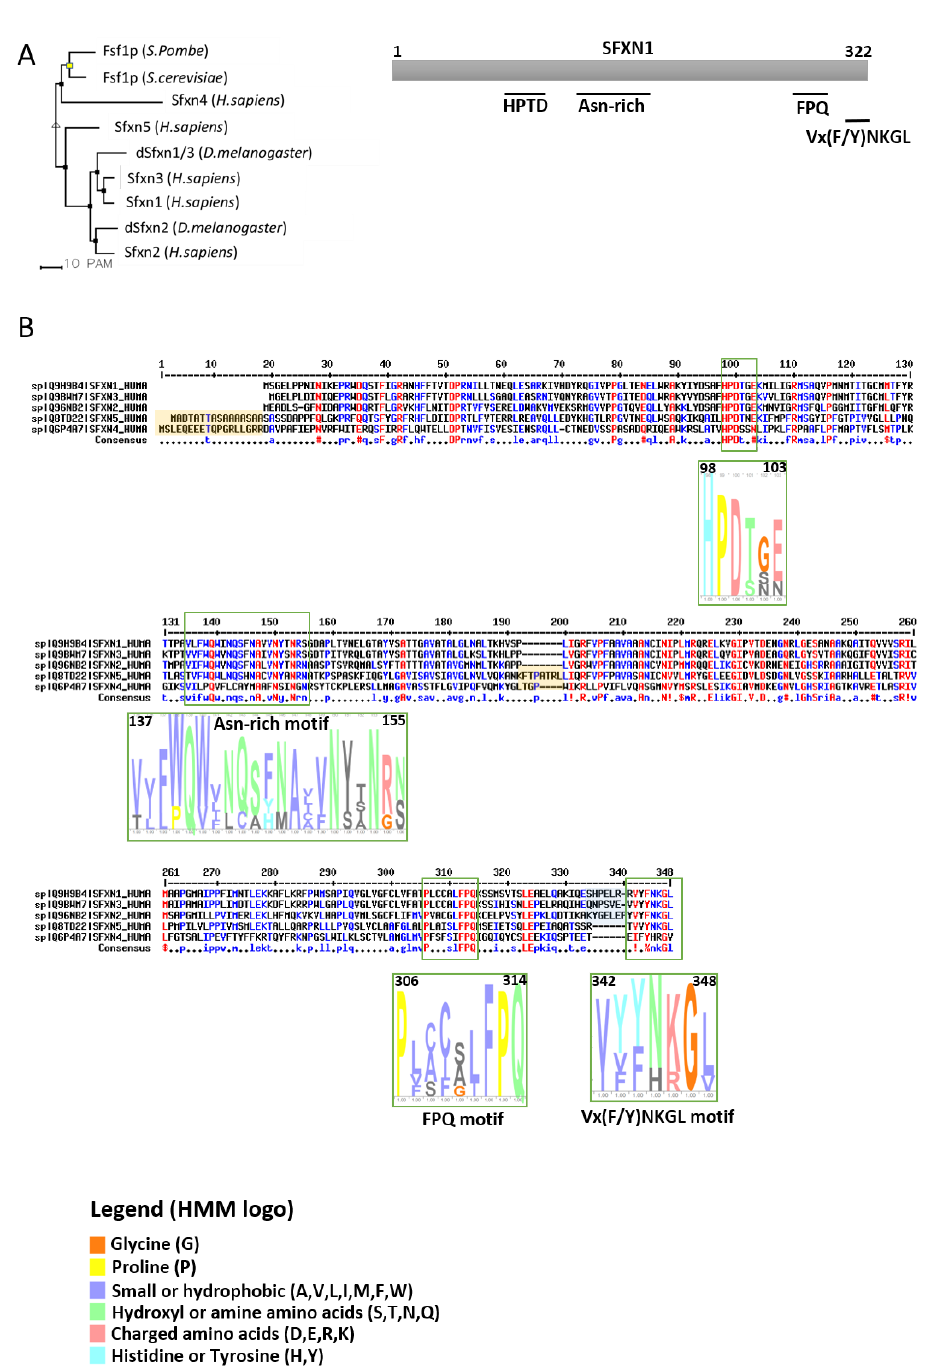
Figure 1. Sideroflexins (SFXNs) form a family of conserved proteins in Eukarya . ( A ). Left panel: Phylogenetic tree obtained using the MultiAlin software (http://multalin.toulouse.inra.fr/multalin/) [10]. Right panel: scheme of the SFXN1 protein and its conserved motifs. ( B ) . Alignment of human SFXNs protein sequences. Red amino acids are for high consensus levels (90%), the blue ones are for low consensus levels (50%). Meaning of symbols found in the consensus line: “!” is for Ile or Val, “$” is for Leu or Met, “%” is for Phe or Tyr,” #” is anyone of Asn, Asp, Glu, Gln. Conserved motifs are shown and highlighted using an HMM logo created using Skyline (http://skylign.org/) with consensus colors for amino acids according to the ClustalX coloring scheme.